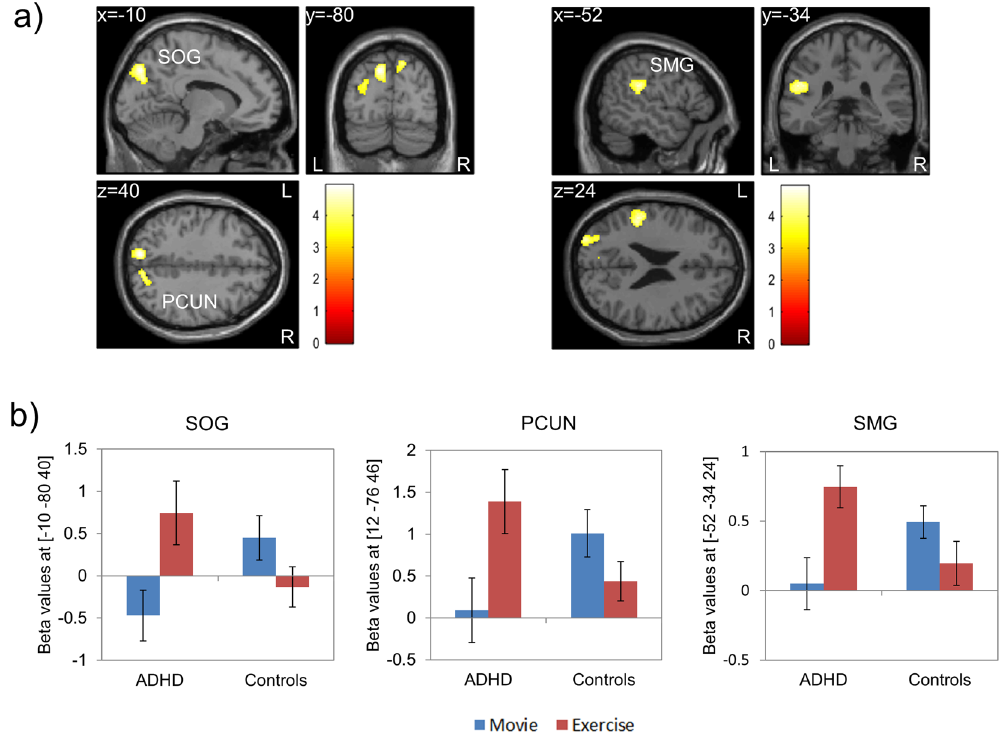
Figure 1. Brain activation during the Go/No-go task for the contrast correct inhibitions : ( a ) activation specific to ADHD (Exercise – Movie) – Controls (Exercise – Movie) ; ( b ) mean beta values of peak coordinates with standard error for each group and condition separately. Activation differences were found in three clusters with peak activation in the left superior occipital gyrus (SOG), right precuneus (PCUN), and left supramarginal gyrus (SMG). p < 0.05 (FWE-corrected on cluster level, initial voxel threshold 0.001